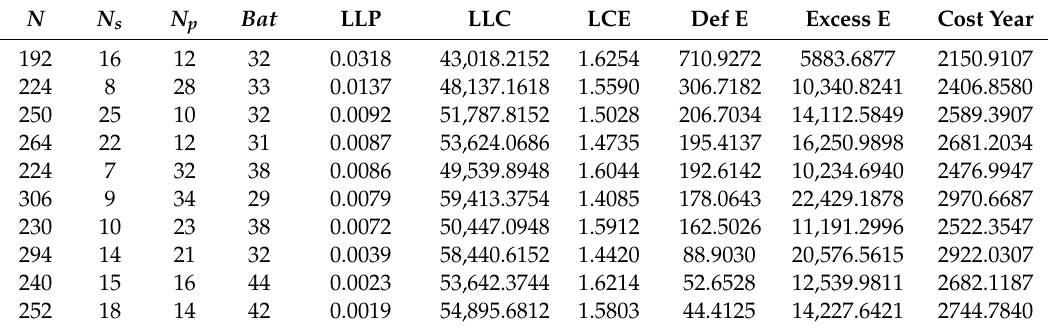
Table 6. Sets of optimal configurations for sizing of the SAPV system using numerical method. N N s N